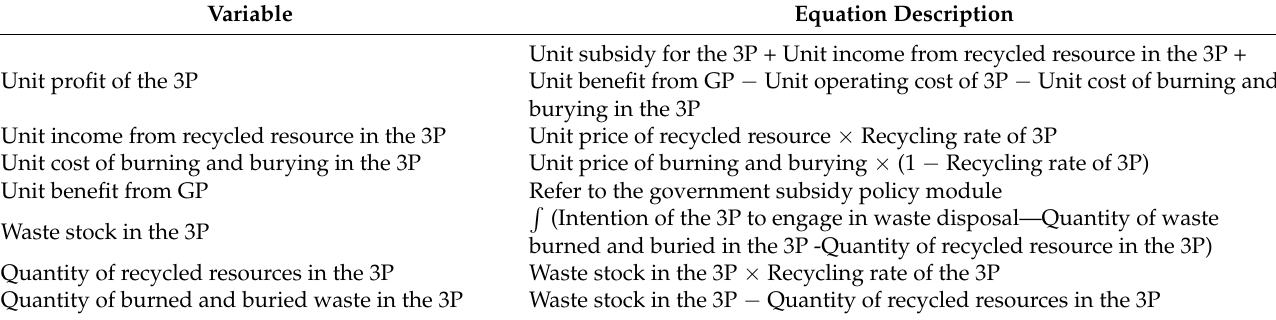
Table 4. Equation description of